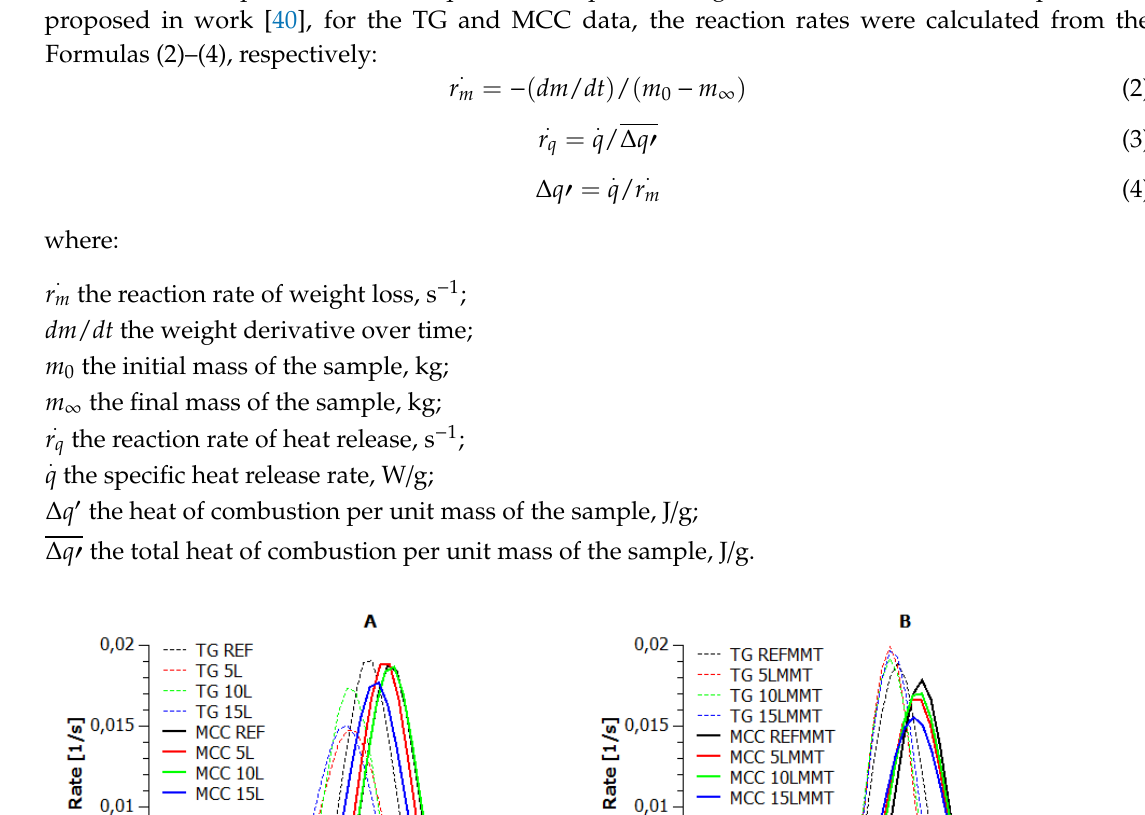
Figure 8. Comparison of the TG and MCC measurements by determining the heat of combustion as a function of temperature during the thermal decomposition of the PA6 samples (heating rate 1 °C/min): ( A ) the samples without nanofiller; and ( B ) the samples with nanofiller. It can be seen that the volatiles released up to 400 °C have a very low calorific value (~2.5 kJ/g for the samples without MMT, and ~3.7 kJ/g for the samples with MMT, approximately), while most combustible volatiles (with the heat of combustion in the range of 20–40 kJ/g) are produced at higher sample temperatures around 500–600 °C. It is worthy to note that the integral heat of combustion differs significantly from these values (~29.23 kJ/g for the samples without MMT and ~28.49 kJ/g for the samples with MMT, approximately). We noticed that, with increasing applied layers, the heat of combustion in the final stage of combustion is reduced to almost half, with 15 layer deposition in both types of samples, with or without MMT. However, the treated samples have a slightly better char forming ability, which was also observed in both the TG and MCC investigations. 3.6. Morphological Analysis